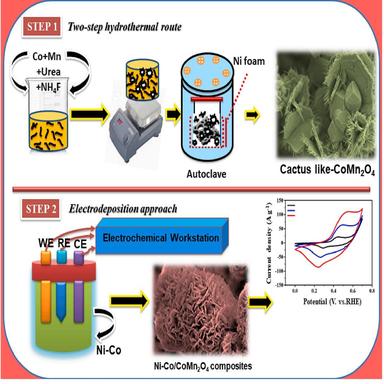
Schematic illustration of the fabrication process of Ni-Co/CoMn2O4 composite materials on a Ni foam skeleton.